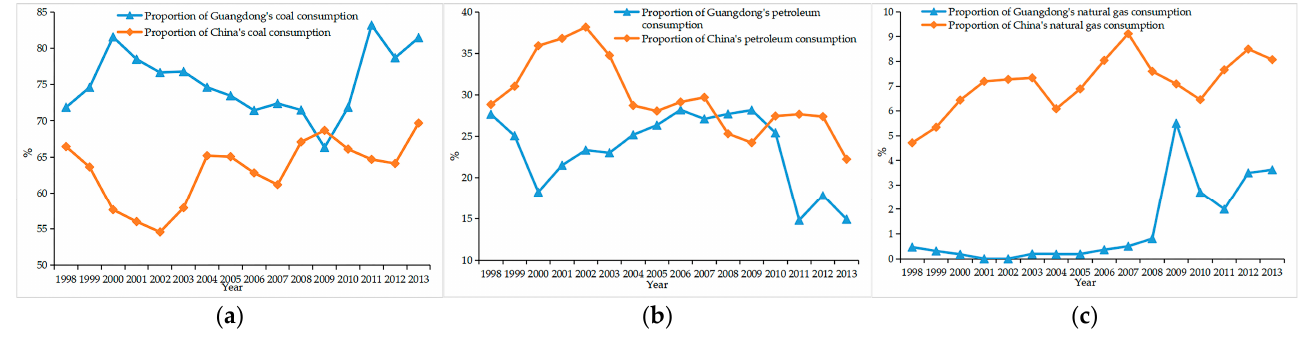
Figure 11. Comparison of the Consumption Ratios of the Industrial Fossil Energy in Guangdong and in the Whole Nation from 1998 to 2013. ( a ) The proportion of coal consumed by the industry in Guangdong and China; ( b ) The proportion of petroleum consumed by the industry in Guangdong and China; ( c ) The proportion of the natural gas consumed by the industry in Guangdong and